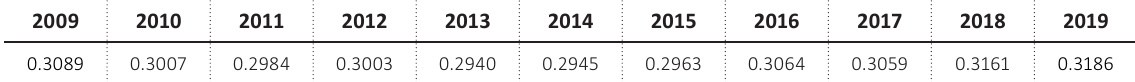
Source: Eurostat